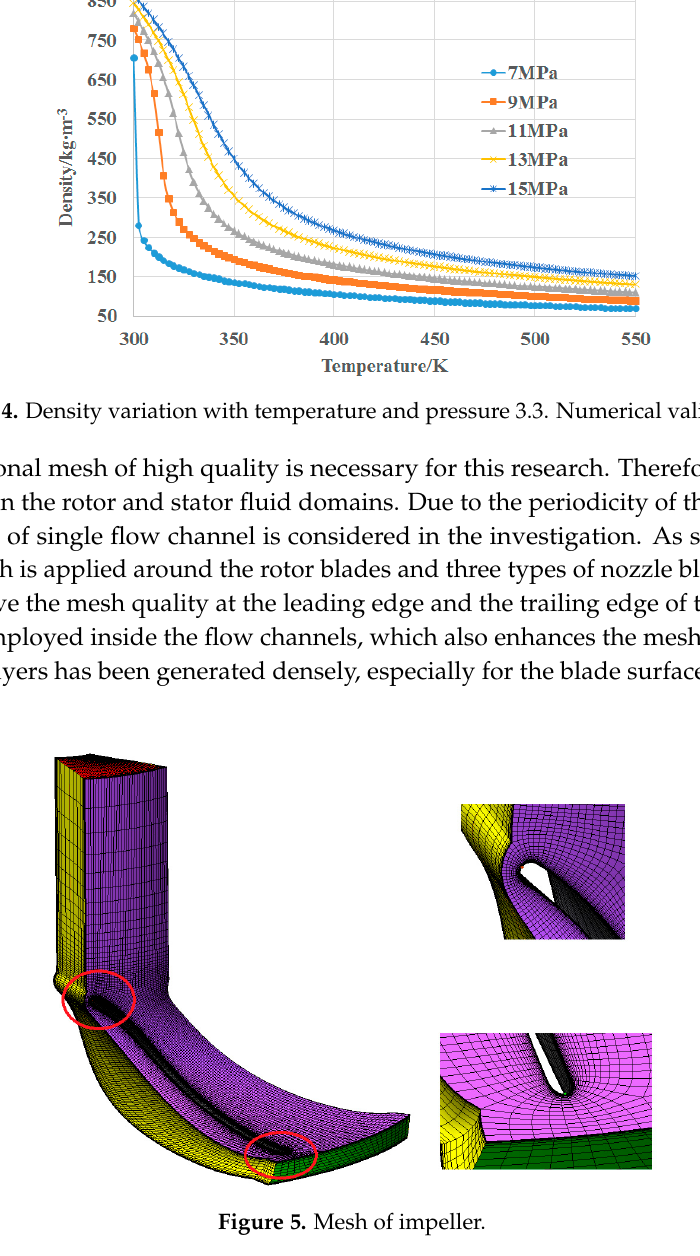
Figure 3. Phase diagram of CO 2 .